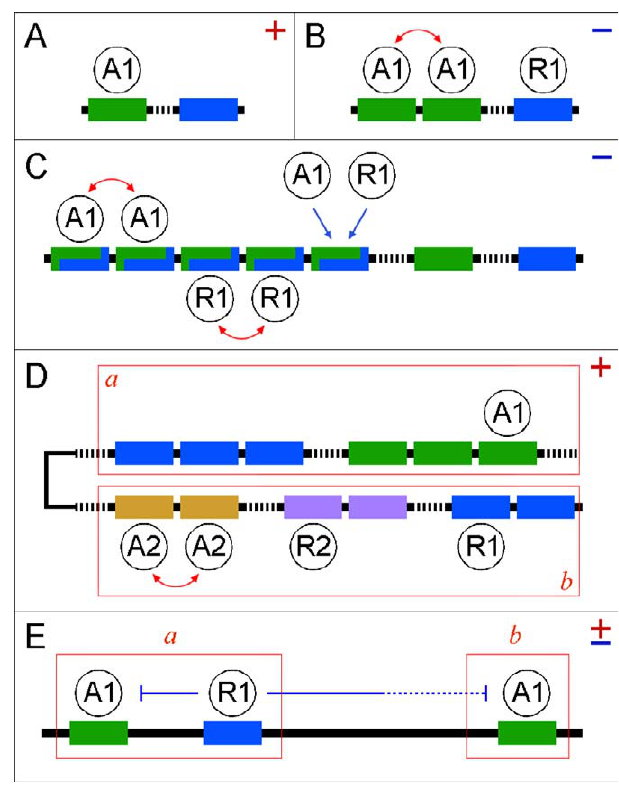
Figure 1. Known Elements of Enhancer Structure (A) A simple regulatory unit, containing an activator (green) and a repressor (blue) binding site. Binding of an activator, but not a repressor, is sufficient for transcriptional activation (indicated by ‘‘ þ ’’ ). (B) A cooperative array and a single repressor site. Red arrow shows the cooperative interaction between transcription factors. Repressor binding blocks enhancer activity (indicated by ‘‘ (cid:2) ’’ ). (C) A competitive array. Blue arrows show the competition between the activator and the repressor; red arrows show cooperativity. (D) A two-module enhancer (modules a and b ) is able to respond to two groups of independent inputs. While the module b is repressed, the module a is active and the enhancer is active, as long as the short-range repression from module a does not reach module b. (E) A short-range repression can reach sites within the same module a , but fails to completely repress an activator site in the distant module b . The outcome of this interaction is a partial inactivation ( 6 sign).